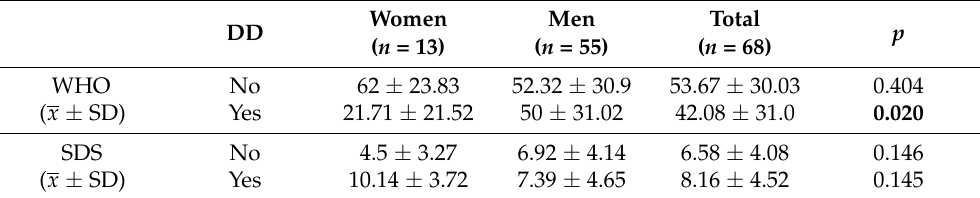
Table 4. Total scores of WHO and SDS in DD vs. non-DD